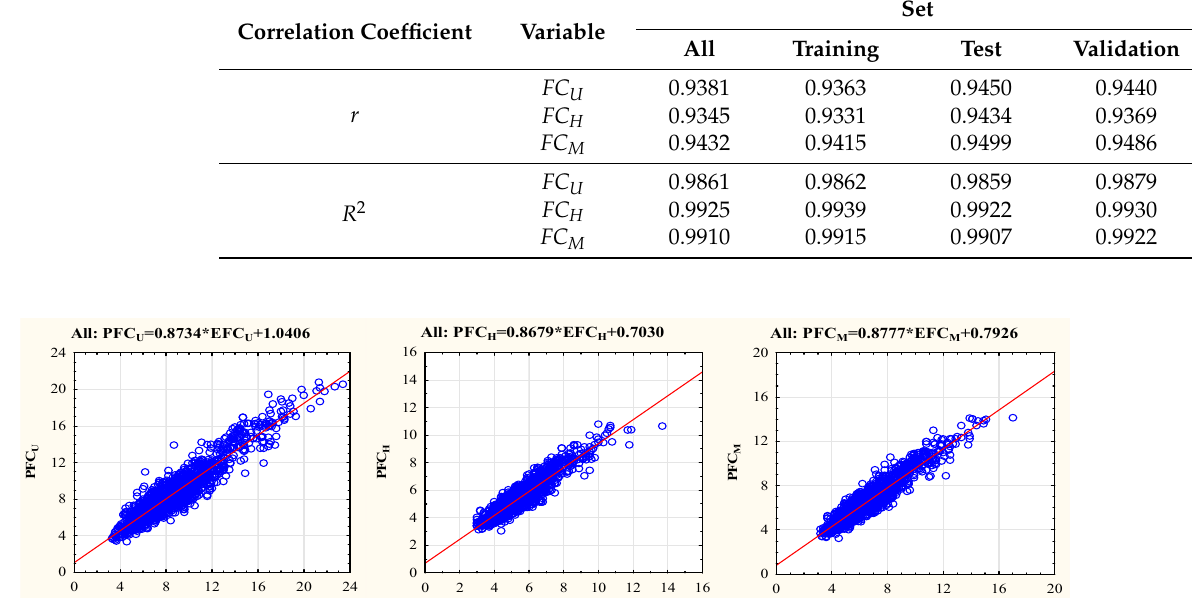
Table 6. Correlation coefficients r and coefficients of determination R 2 for the MLP 22-10-3 artificial neural network. Correlation Coefficient